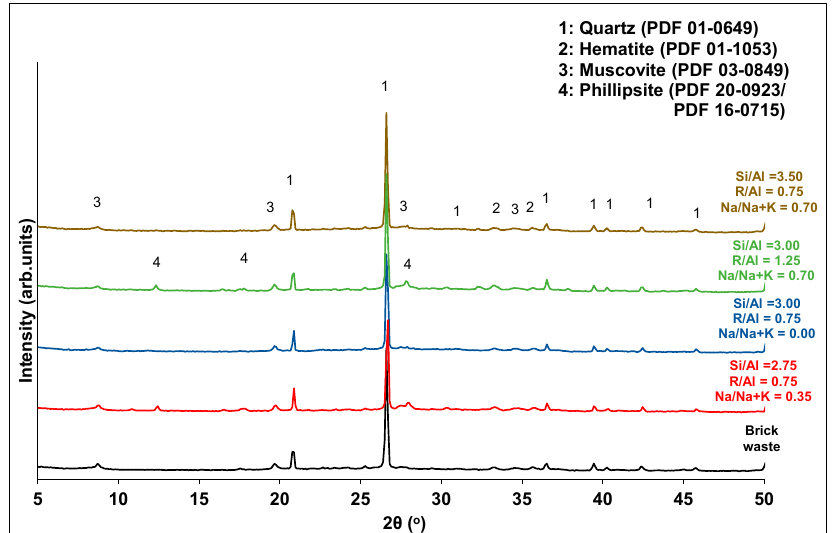
Minerals 2020 , 10 , x FOR PEER REVIEW Figure 6. XRD patterns of brick precursor and selected geopolymer samples. Figure 6. XRD patterns of brick precursor and selected geopolymer samples.